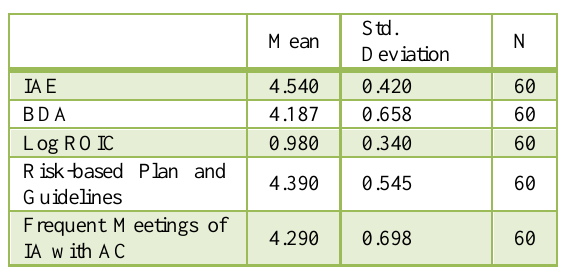
Table 2: Descriptive Statistics